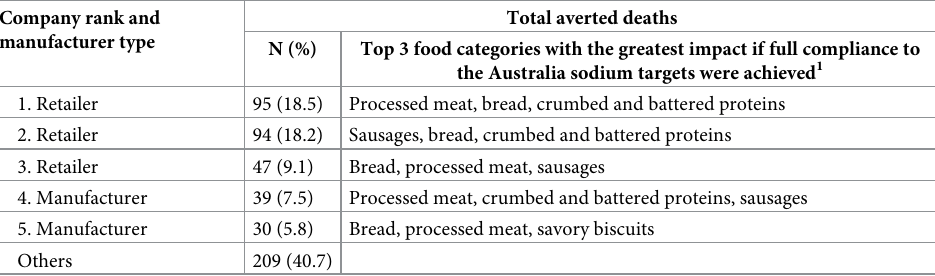
Table 3. Total averted deaths per year across top 5 companies with greatest potential to reduce death from full compliance with the Australian government’s 2020 sodium reformulation